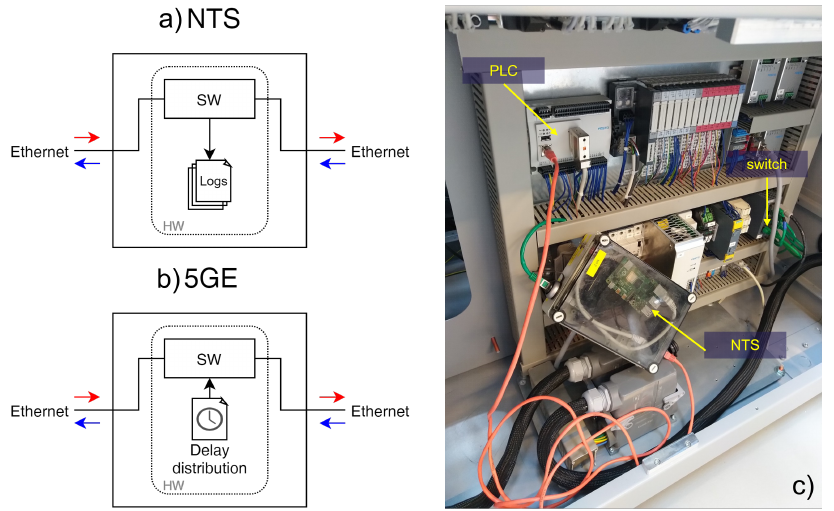
Figure 3. ( a ) Functional block diagram of the NTS. ( b ) Functional block diagram of the 5GE. ( c ) Picture of the NTS/5GE (v2) device deployed within a production line module. Under such exact same deployment configuration, the box can be used to either logging the data traffic to and from a PLC, or to introduce communication delays to emulate the connectivity of the PLC over 5G